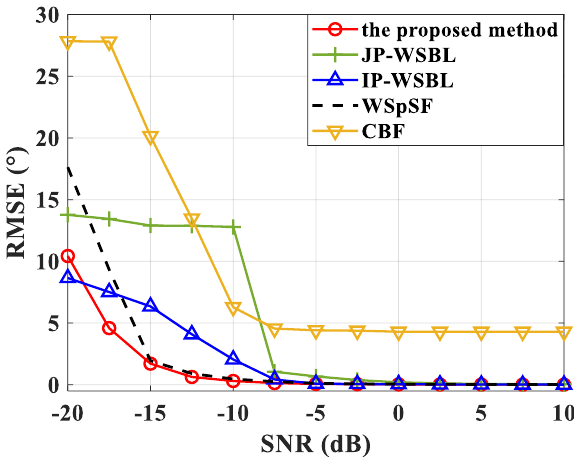
Figure 6. The RMSE versus the SNR under Case II.